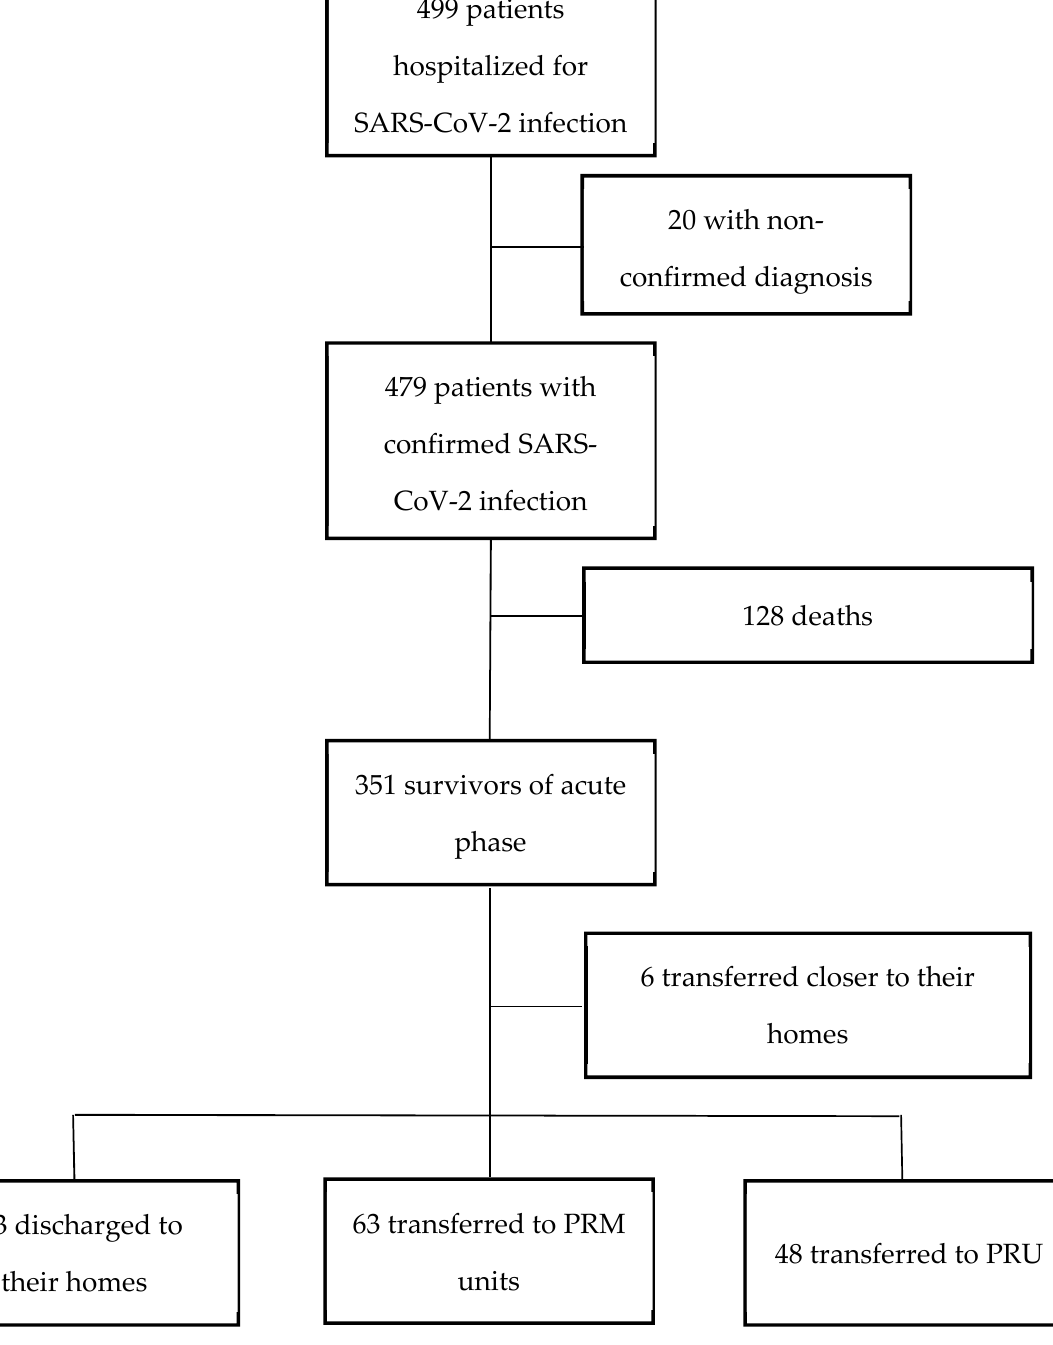
Figure 1. Flowchart of the study population.